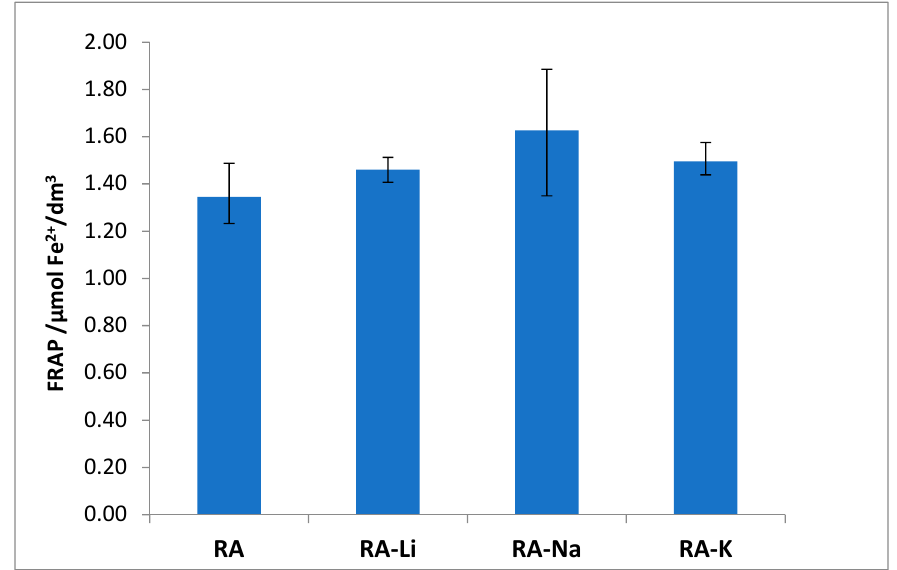
Figure 8. Reducing power of the rosmarinic acid (RA) and its lithium, sodium, and potassium salts evaluated by FRAP (Fe 3 + ion reduction capability) assay.